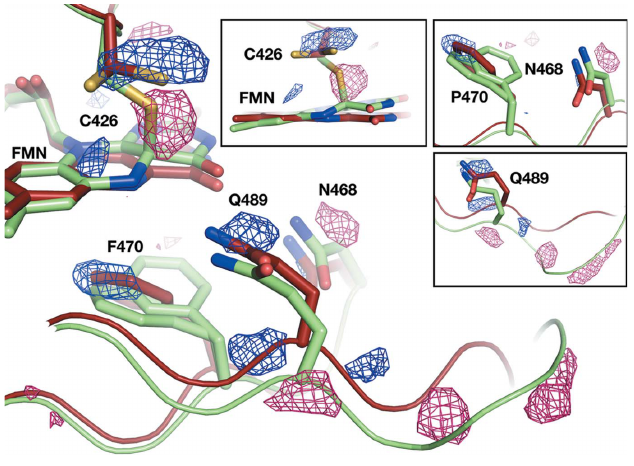
Figure 4 Identification of structural rearrangements around the FMN occurring during the relaxation process. Fourier difference map calculated between R 35 00 and a dataset for the PS equilibrium. Positive and negative peaks are displayed as blue and dark pink meshes, respectively. The L-state (green) and D 00 -state (firebrick) models are displayed as ribbons and sticks. Alternate orientations for key residues are shown as insets.